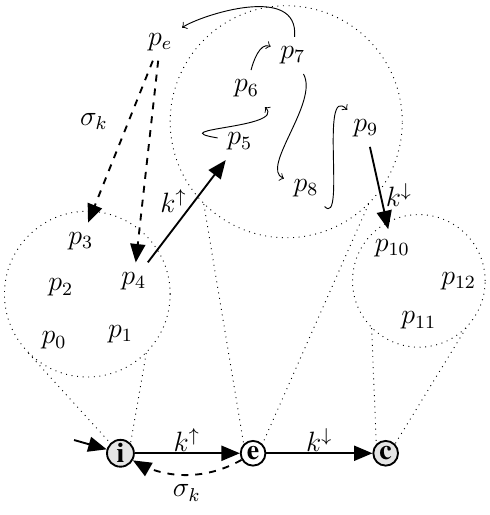
Figure 6. Mapping between states for an operation k , bottom, and physical states, top. σ k is a placement event for k .